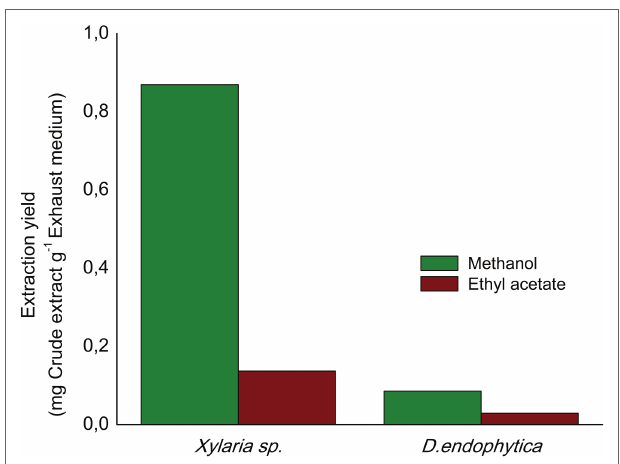
FIGURE 6 | Extraction yields obtained from the alternative extraction procedure with polymeric resin Amberlite X.A.D. 16 N using as eluents: ethyl acetate (EtOAc) and methanol.